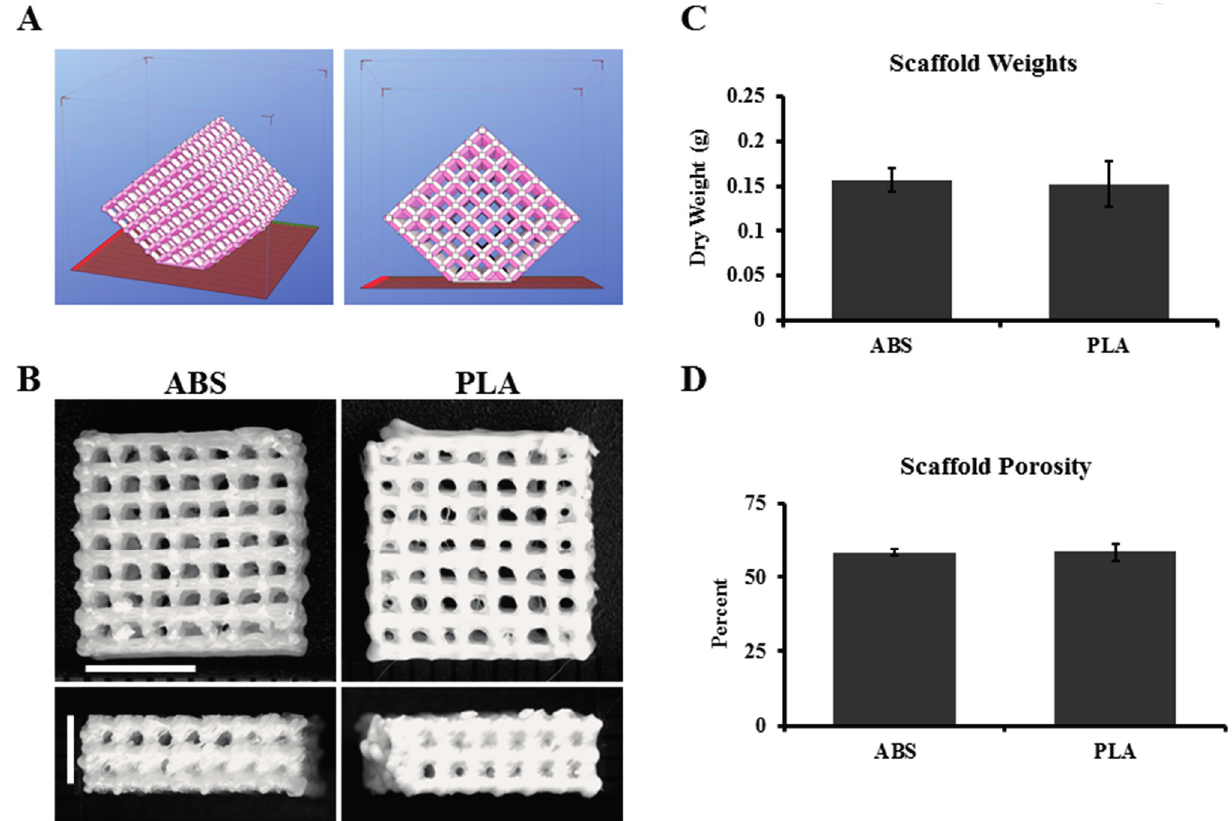
Figure 1. ABS and PLA scaffold design. Construct design was downloaded from the freeware website http://www.thingiverse.com/thing:45228/#files. ( A ) Representative .stl images of scaffold structure; ( B ) representative images of printed ABS and PLA scaffolds. Horizontal scale bar: 0.5 cm; vertical scale bar: 0.3 cm; ( C ) Quantification of scaffold weight; ( D ) quantified porosity of the ABS and PLA scaffolds used in the studies. Error bars represent ± SD, n =